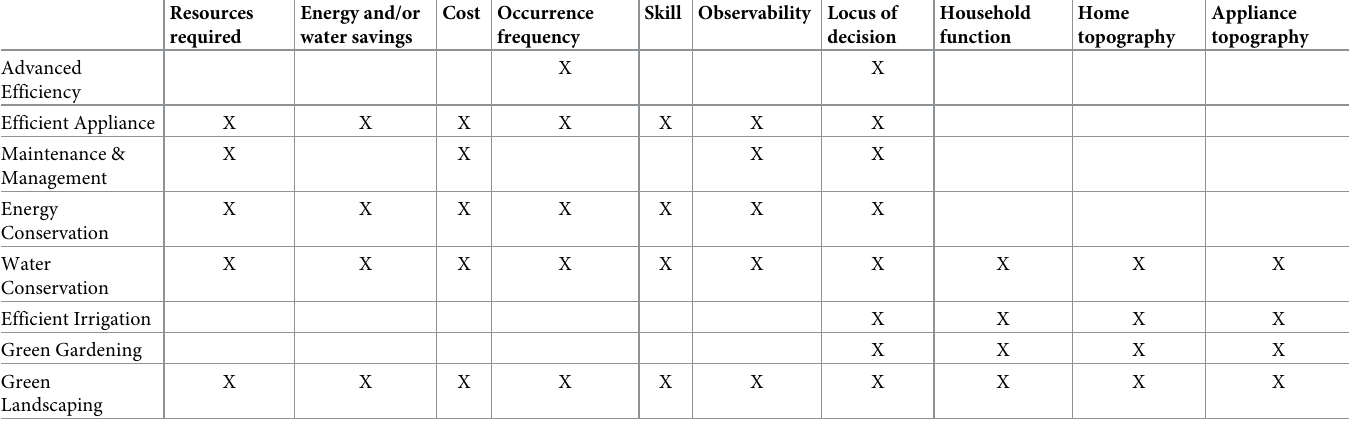
Table 4. Distinguishing behavioral attributes (per Boudet et al., 2016) of identified water-energy-saving measure classes. Resources